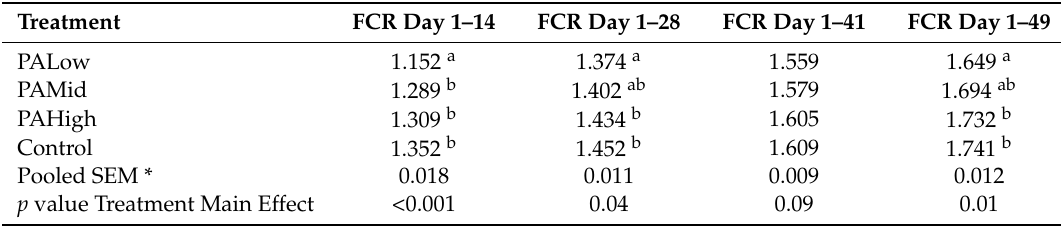
Table 7. Feed conversion ratio during growout in Experiment 2.